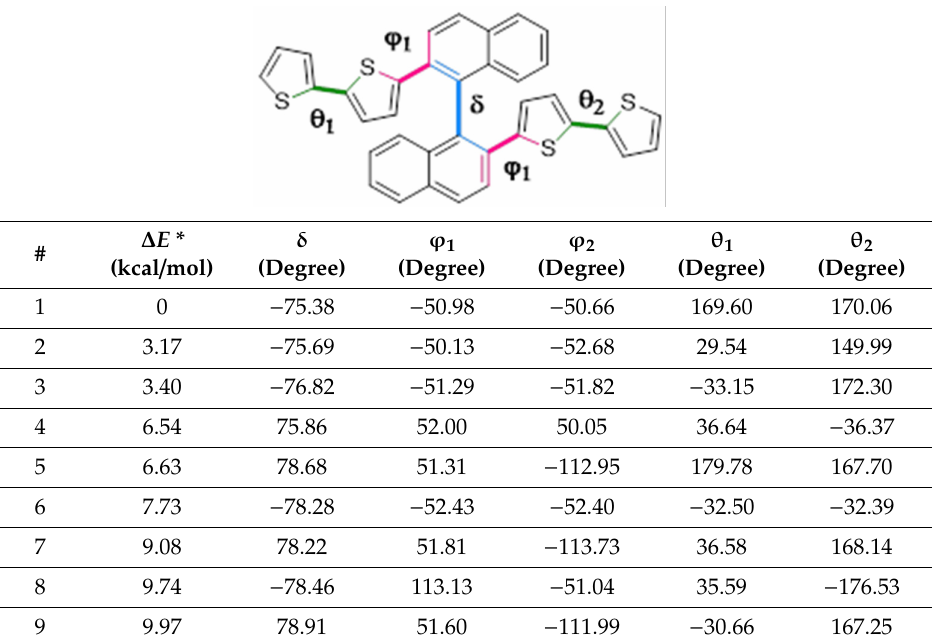
Table 4. Dihedral angles of Naph 2 T 4 obtained by force field